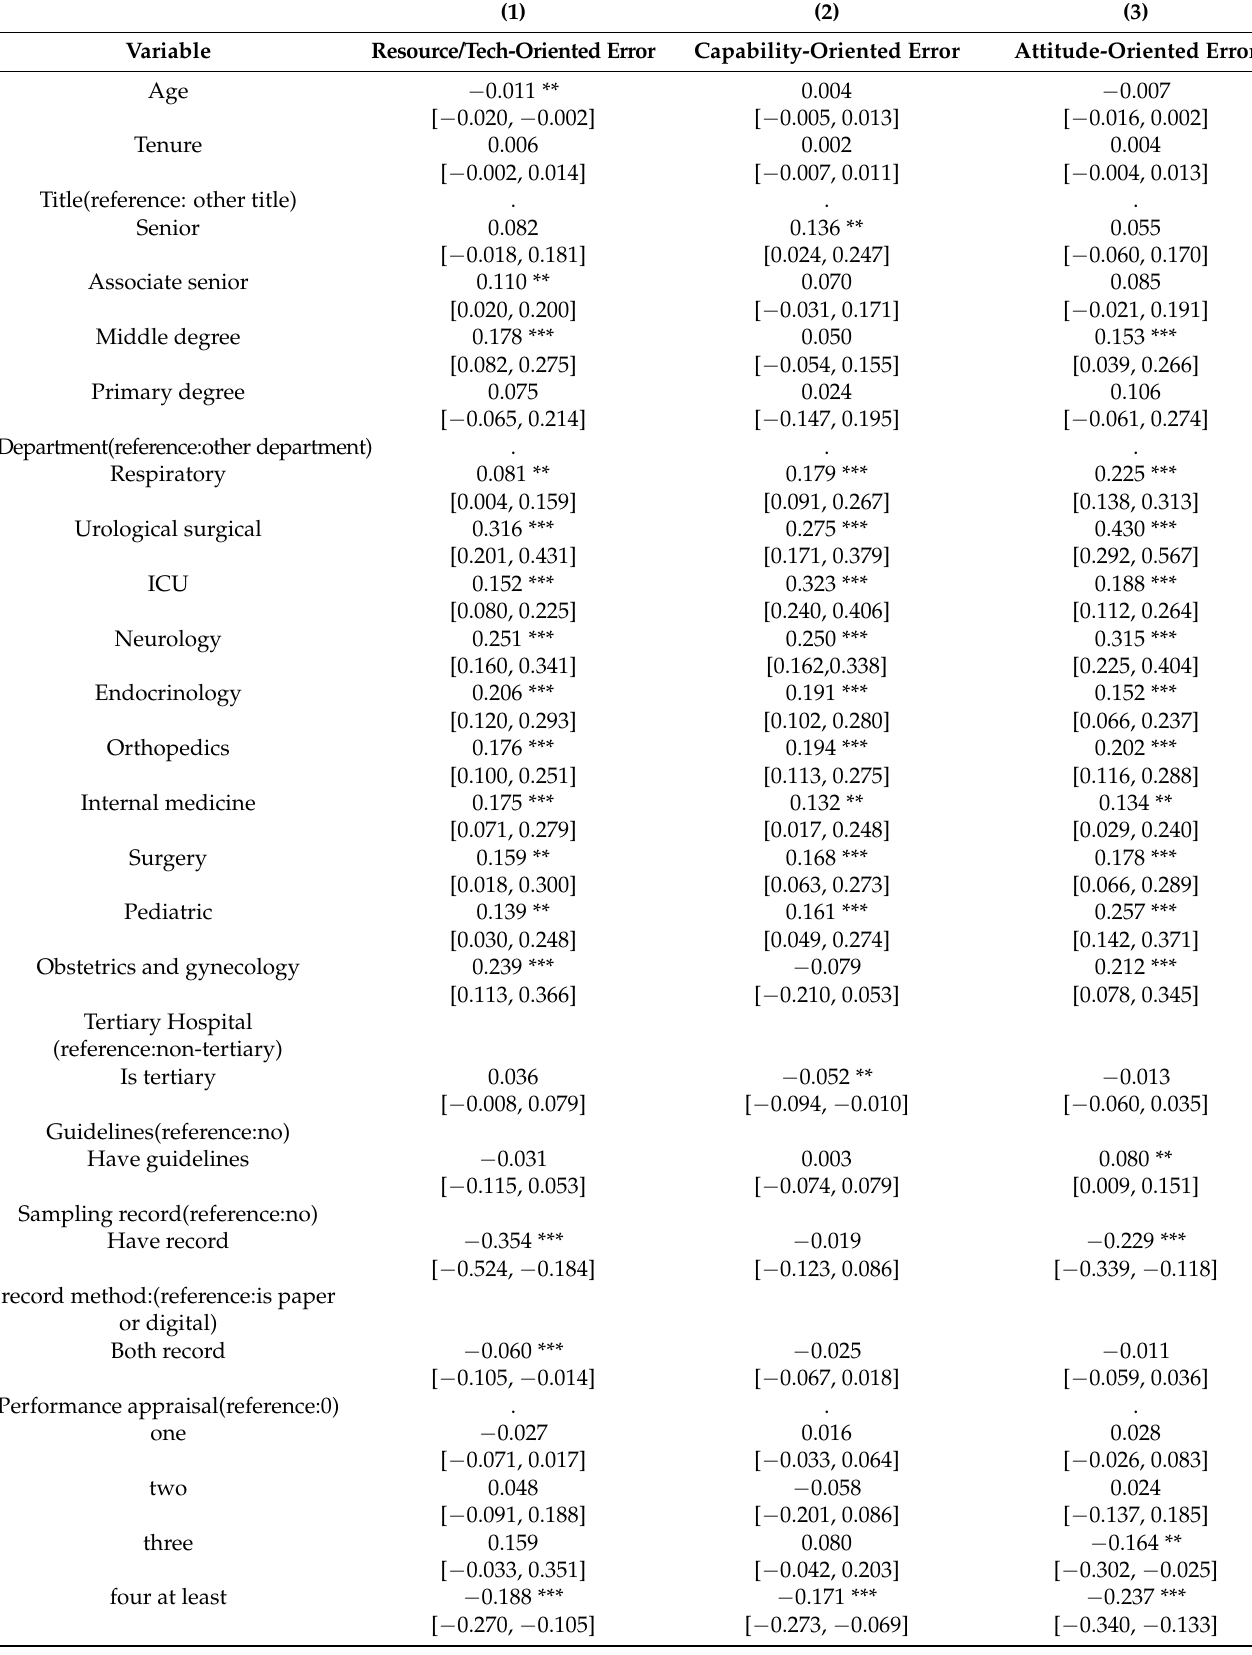
Table 3. Results of Ordinary Least Square regression on Sampling errors and its influencing